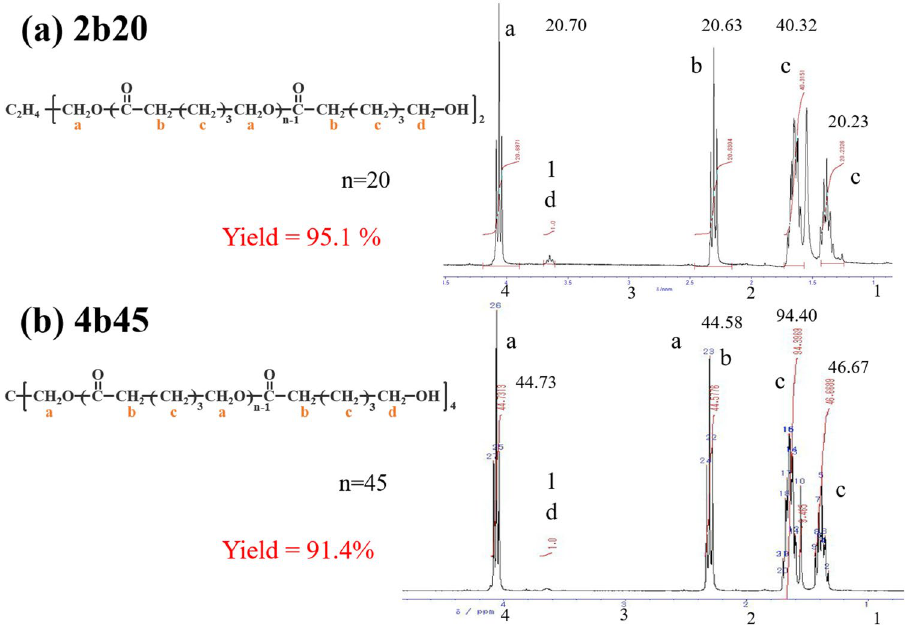
Figure 1. 1 H NMR spectra of linear (a) and tetra-branched (b)